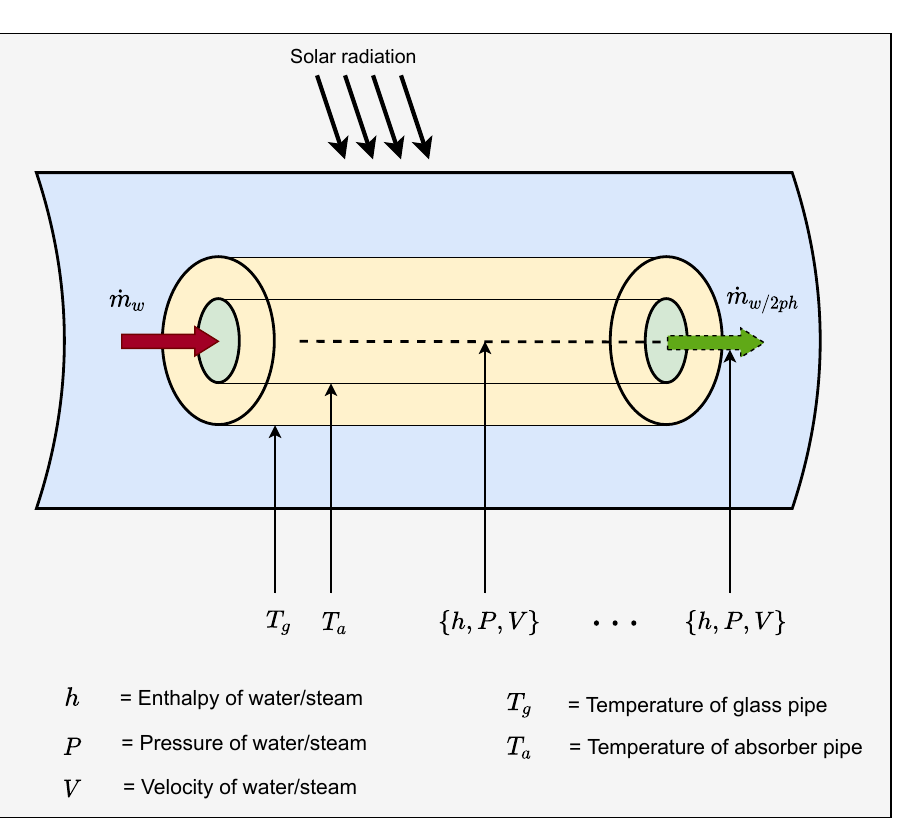
Figure 4. Parameters and dynamic variables of